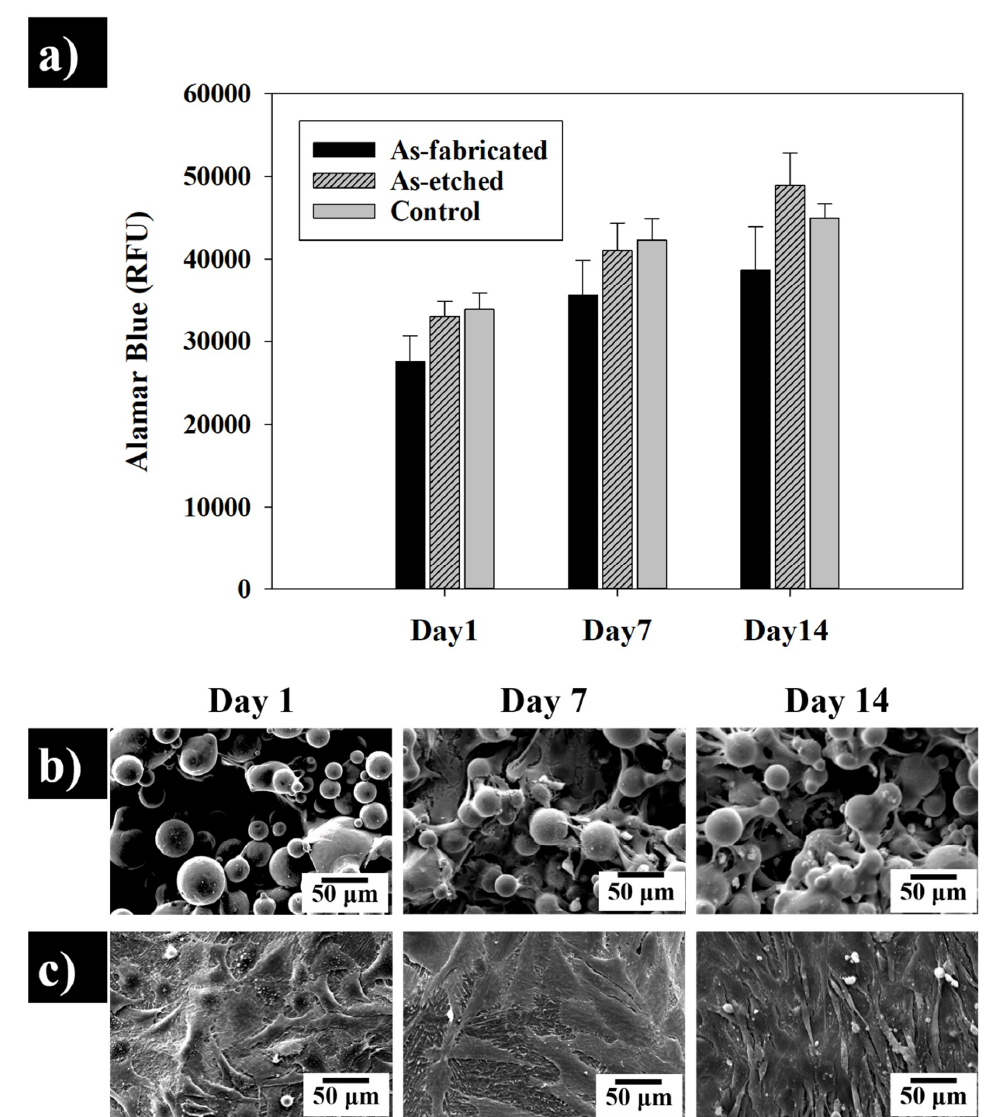
Figure 11. ( a ) Comparison of the metabolic activity of SAOS‐2 cells seeded on as‐fabricated Ti‐6Al‐4V surface, as‐etched and control (tissue culture plastic) surface and ( b , c ) SEM micrographs of the seeded cells grown on the surface of SLMed Ti‐6Al‐4V in as‐fabricated status and after etching on days 1, 7 and 14.